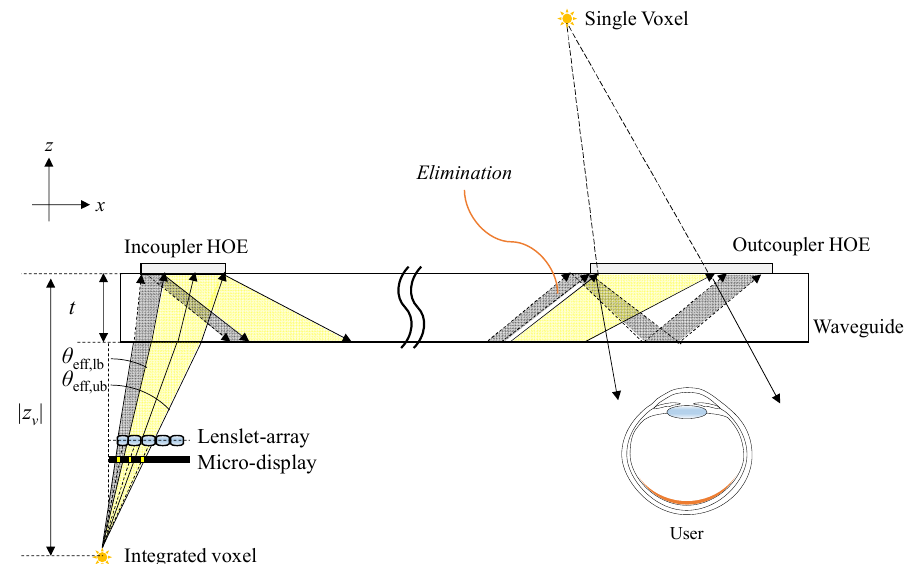
Figure 4. The principles of emission angle adjustment method using the InIm system for solving the voxel duplication problem.